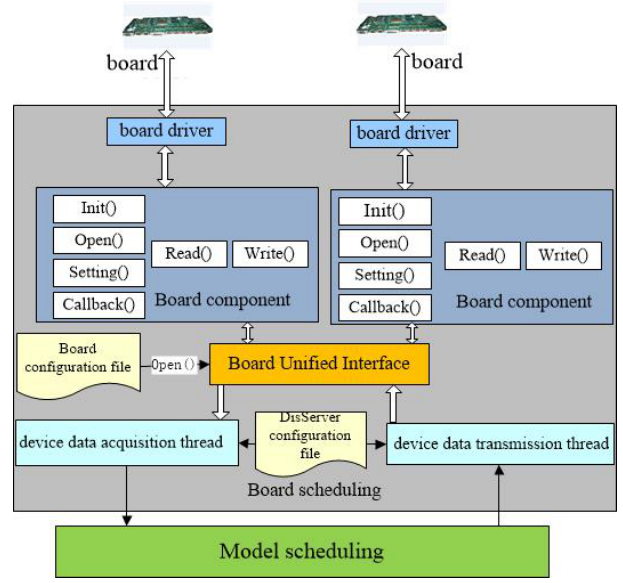
Figure 5. Board scheduling framework.